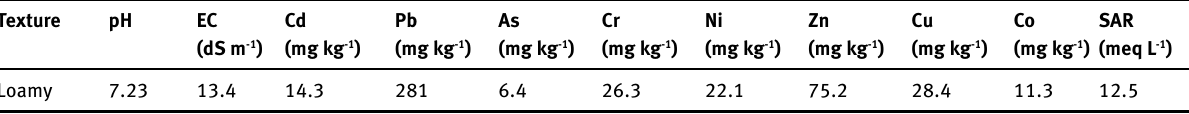
Table 2: The physicochemical properties of top soil from the cultivated field